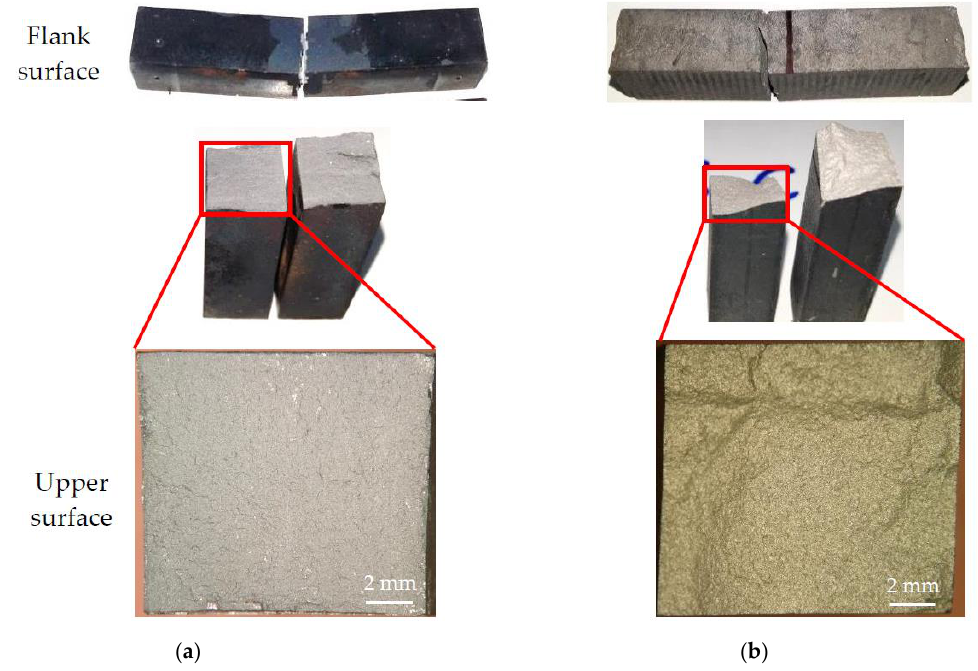
Figure 18. Images of the fractured test specimens from the flank and upper surfaces: ( a ) un-reinforced (R0T60); ( b ) Fe + 20 vol.% B 4 C (R20T60)